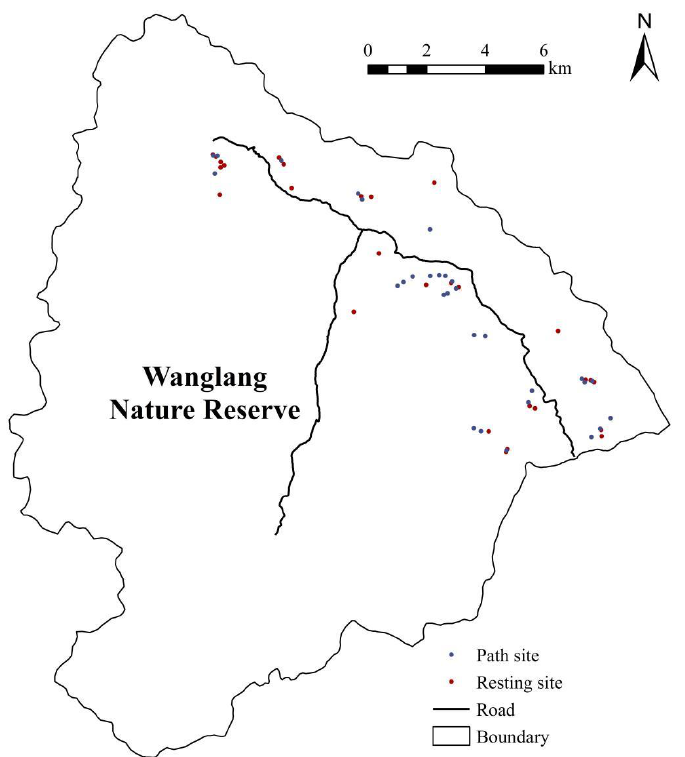
Figure 1. Distribution of resting and path sites (resting site: more than ten feces at a site; path site: one or two feces at a site).